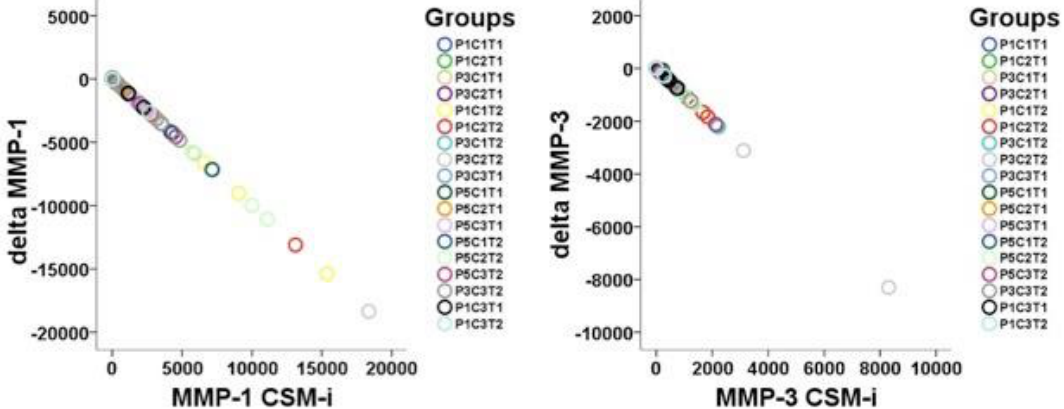
Figure 1. Visualization of linearity between CSM-i and the mathematical difference of CSM-e minus CSM-i ( ∆ target) of all P, C, and T assemblies possible ( n = 18) for MMP-1 and MMP-3.